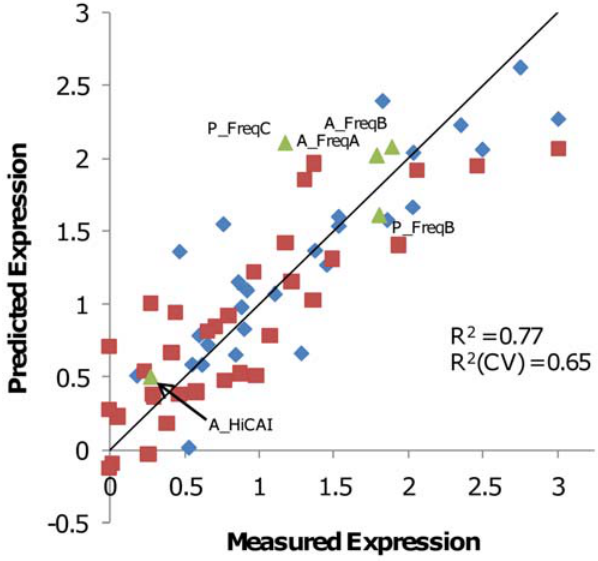
Figure 6. New gene variants express as predicted by the combined PLS model. For each variant the measured expression level was plotted against the expression predicted from a PLS model using genetic algorithm-selected codons. Polymerase variants (34 red squares) and scFv variants (27 blue diamonds) were included in the training set, expression in each set was normalized to the highest expression level in that set (=3). Green triangles show measured and predicted expression of 5 new genes not included in the training set.